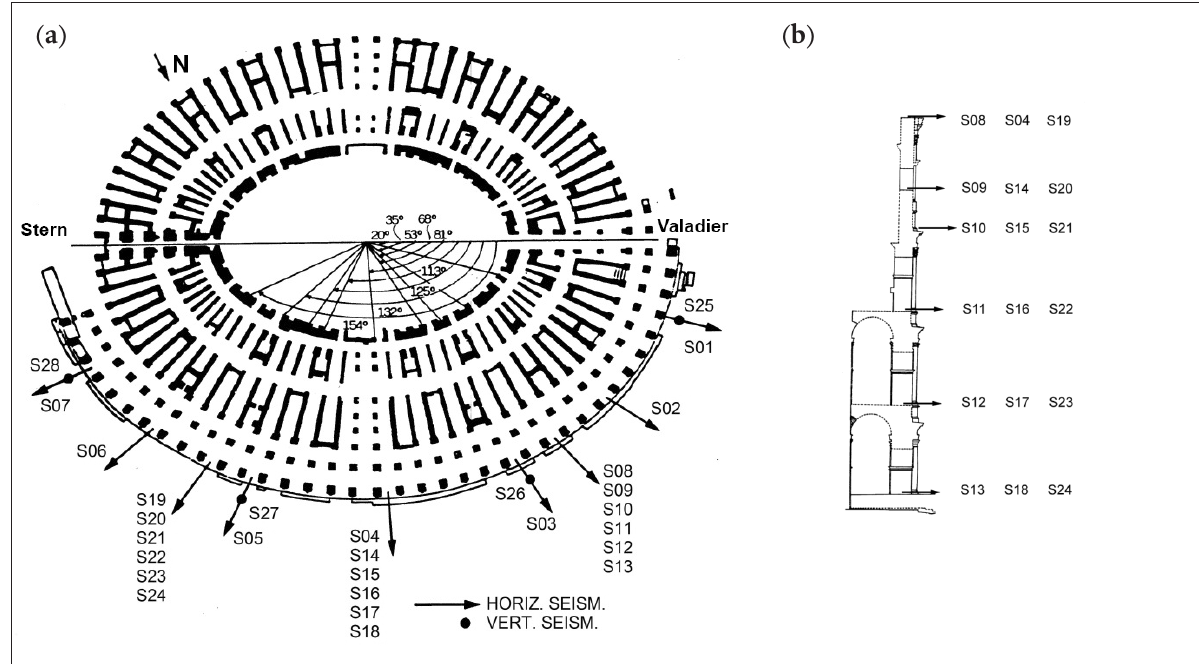
Figure 3. Seismometer locations: (a) plan view and (b) vertical